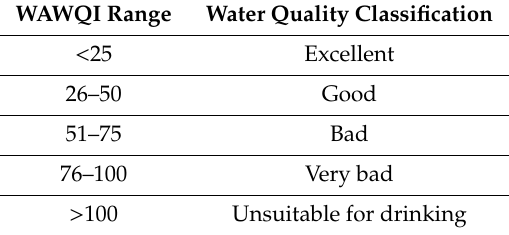
Table 1. Water quality classification for human consumption using the weighted arithmetic water quality index (WAWQI)